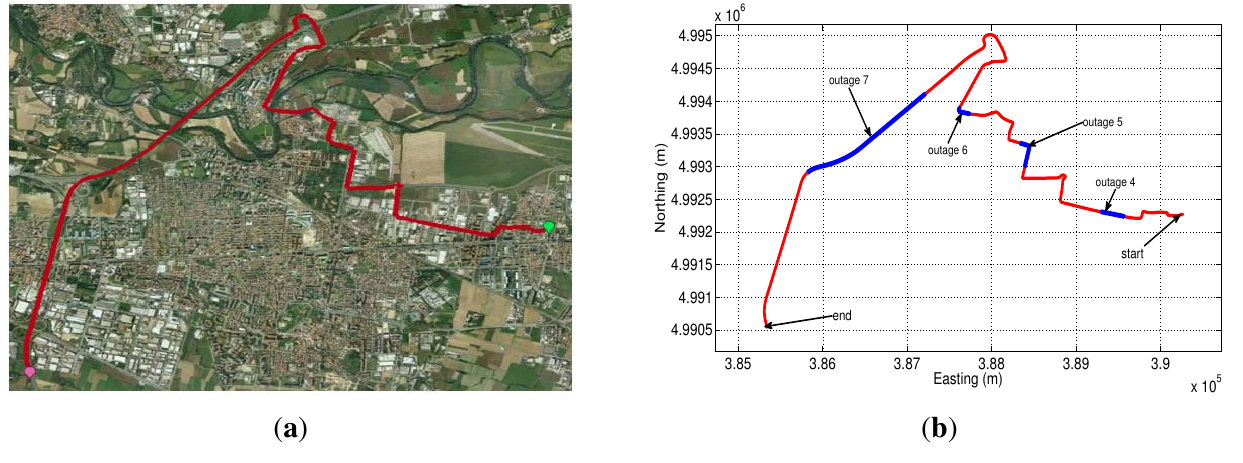
Figure 23. ( a ) Second trajectory test in Google Earth; ( b ) second trajectory test in Matlab with the GPS outages that were introduced